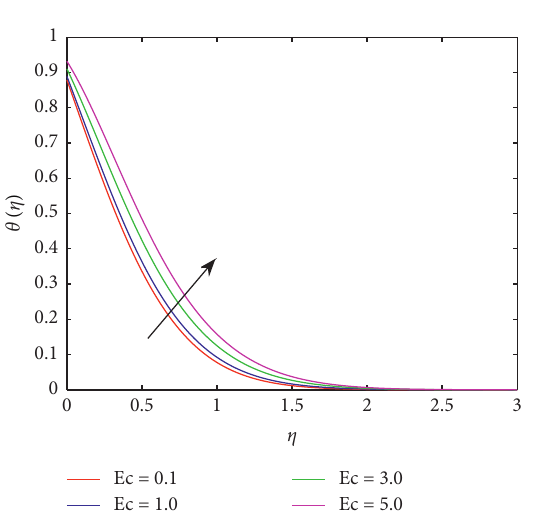
Figure 6: Variation due to Rd in θ ( η ) .